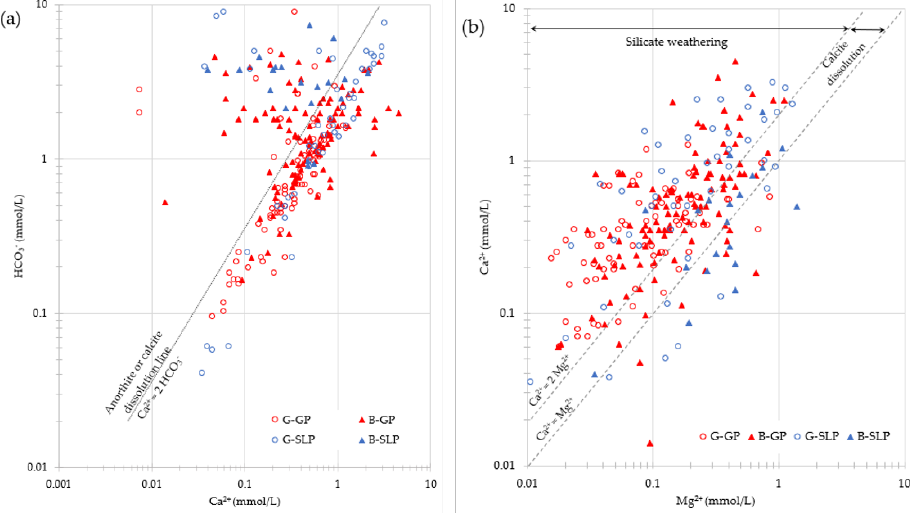
Figure 5. Plots of ( a ) Ca 2+ vs. HCO 3 − concentrations and ( b ) Mg 2+ vs. Ca 2+ concentrations. The groundwater samples are identified according to geological province and aquifer type. The equilibrium equations for calcite and anorthite weathering by carbonic acid are plotted in Figure 5a and Figure 5b, and the equilibrium line for the dissolution of dolomite is plotted in Figure 5b. GP, Grenville Province; SLP, St. Lawrence Platform; G: granular aquifer; B: bedrock aquifer.